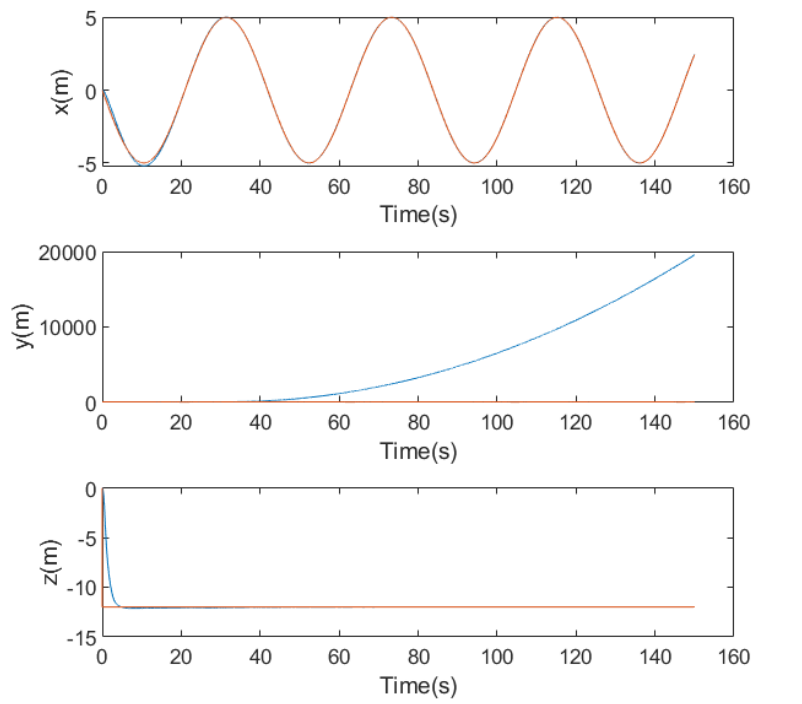
Figure 18. Bias fault: control result without sensor handling: the position profile (red line–desired, blue